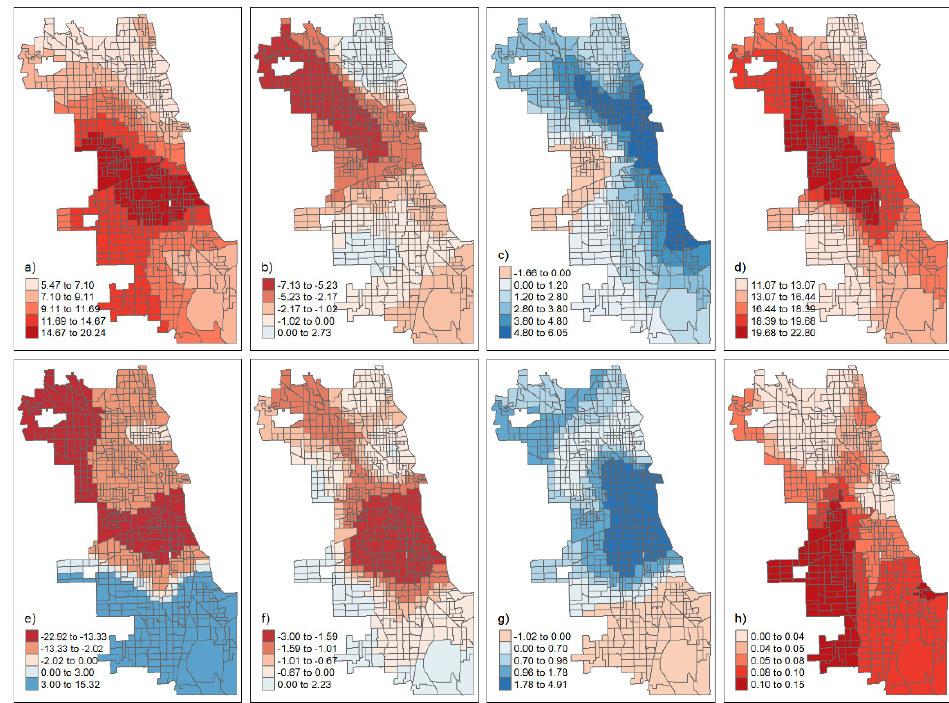
Figure 3. GWR coefficients of variables ( a ) Poverty, ( b ) Limited English, ( c ) Disabled, ( d ) No high school, ( e ) Mixed land use, ( f ) Bike ratio, ( g ) Tree ratio, ( h ) Vacant housing.